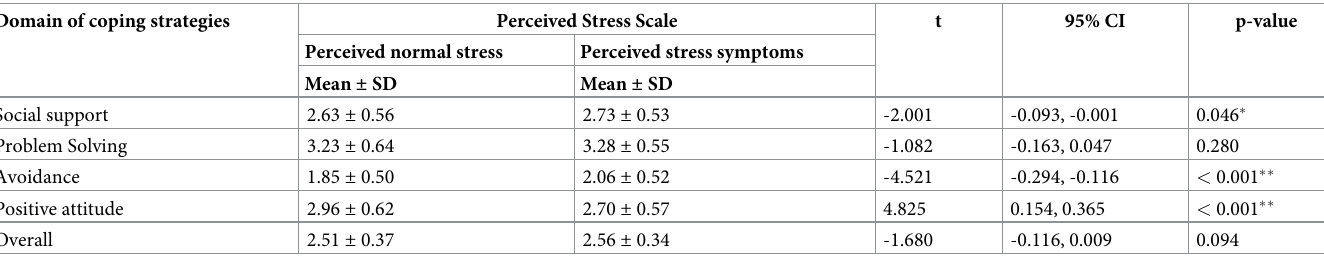
Table 4. Comparison of the use of coping strategies based on the difference of perceived stress symptoms. Domain of coping